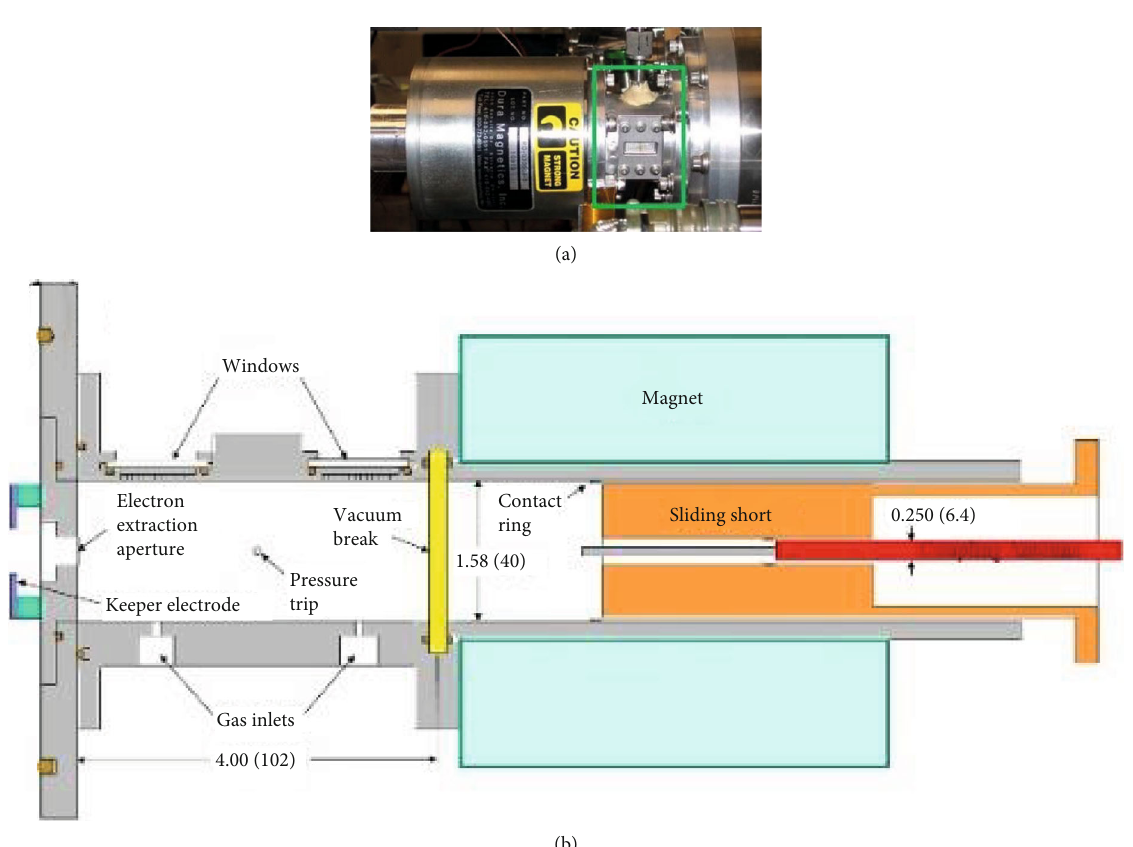
Figure 13: A 2 stage ABCHT: (a) ABCHT mounted to a vacuum chamber; (b) section view of cavity, dimensions in inches (mm)